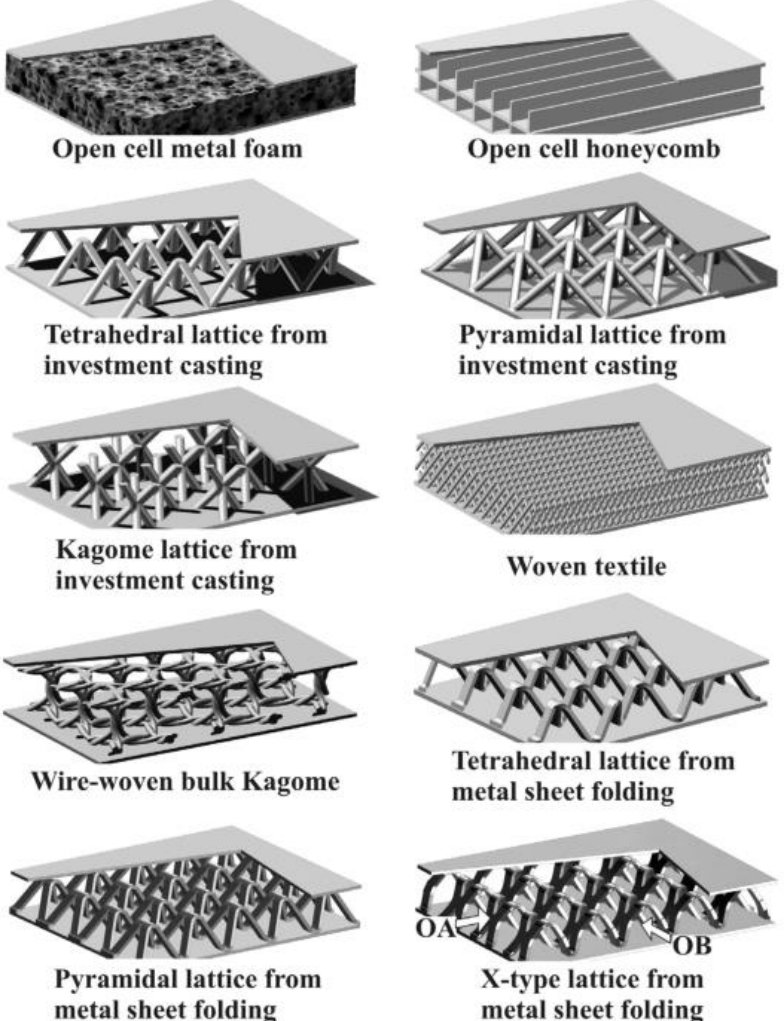
Figure 7. Several common lattice structures with different unit elements. Reprinted/adapted with permission from Ref. [22]. 2017, Elsevier Ltd.